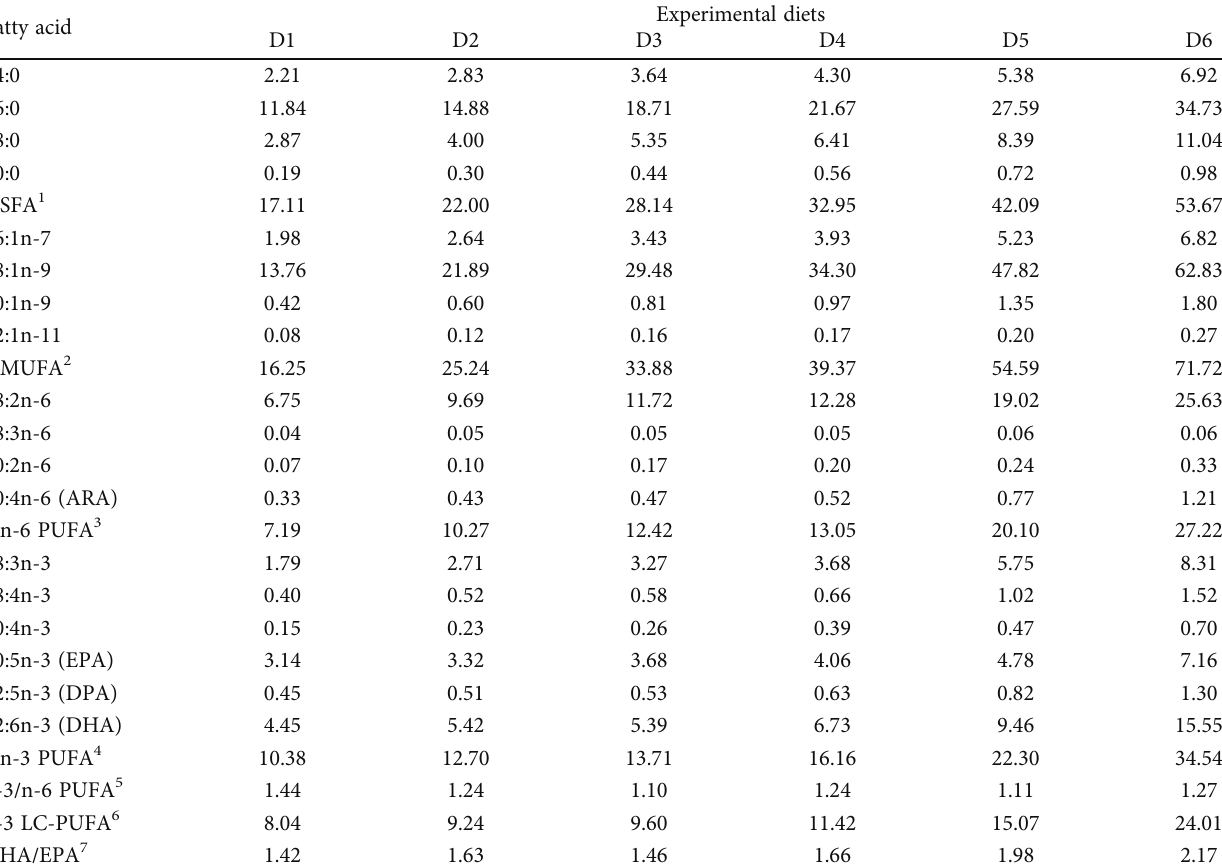
Table 2: Fatty acid composition (mg/g, dry matter) of the experimental